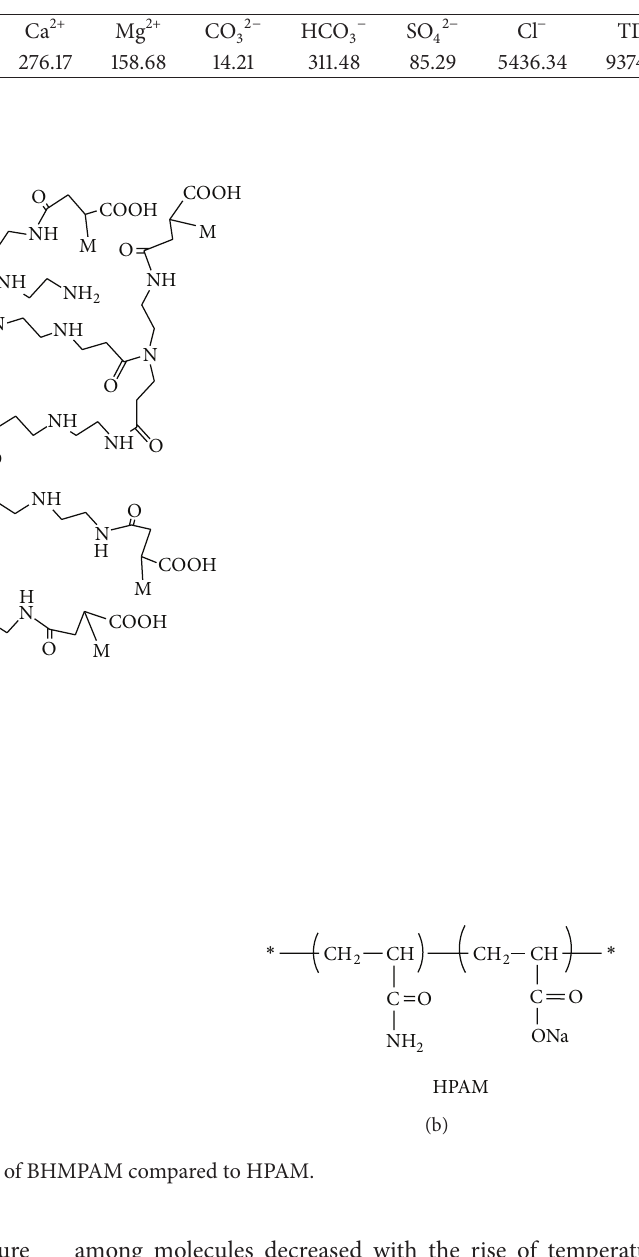
Table 1: The ionic composition of synthetic formation water.